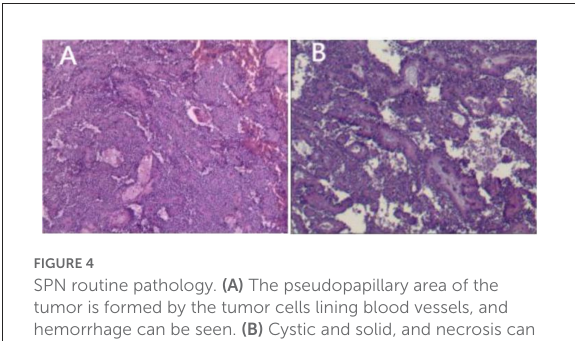
FIGURE4 SPN routine pathology. (A) The pseudopapillary area of the tumor is formed by the tumor cells lining blood vessels, and hemorrhage can be seen. (B) Cystic and solid, and necrosis can be